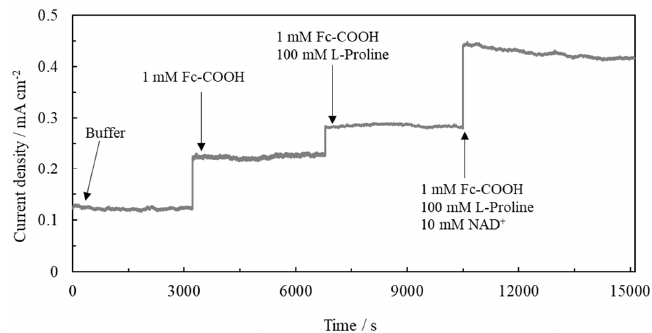
Figure 6. Current density in tetra-enzyme immobilized electrode using a microfluidic